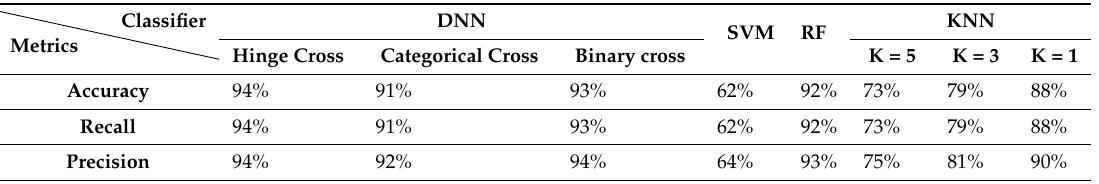
Table 9. Results of preference recognition using holdout validation and different classifiers: DNN, SVM, RF, and KNN.